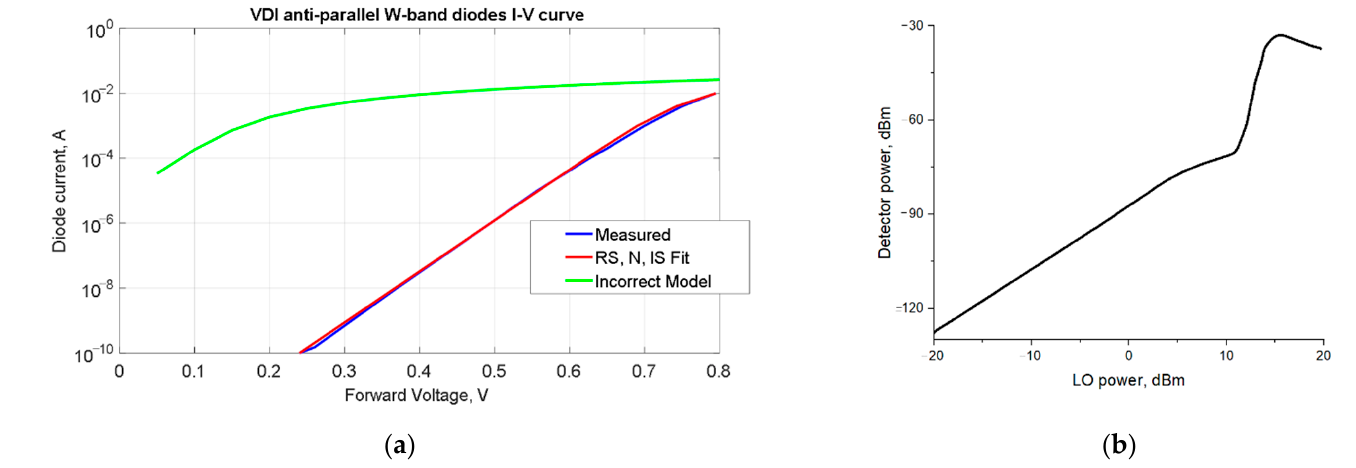
Figure 7. Comparison of volt-ampere (I-V) curves of the measured and simulated parameters of anti-parallel diode pair, used in the design ( a ) and the detector signal (I or Q) as a function of LO power ( b ).